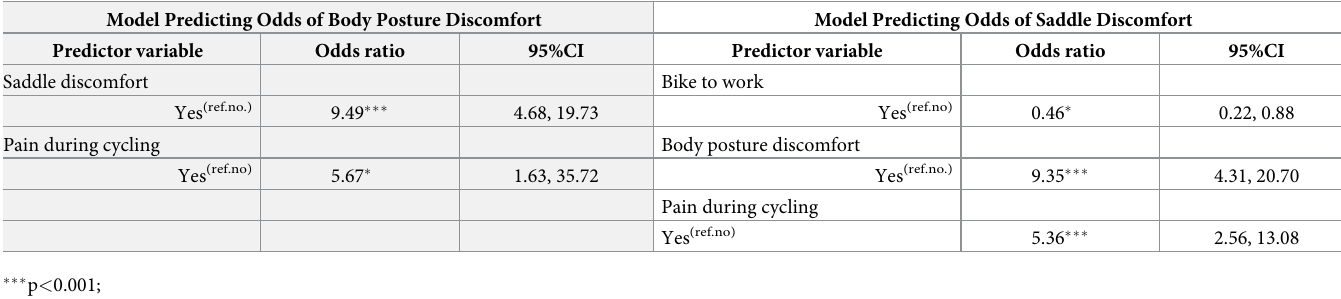
Table 4. Logistic regression models assessing the odds of reporting body posture discomfort and saddle discomfort while cycling, respectively. Referent categories for models were not reporting body discomfort and saddle discomfort while cycling, respectively. Model Predicting Odds of Body Posture